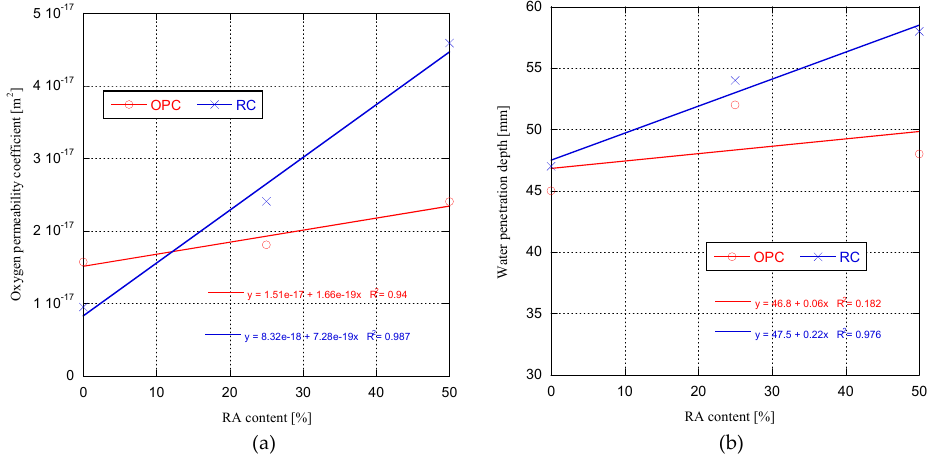
Figure 8. Oxygen permeability coefficient ( a ) and water penetration depth ( b ).